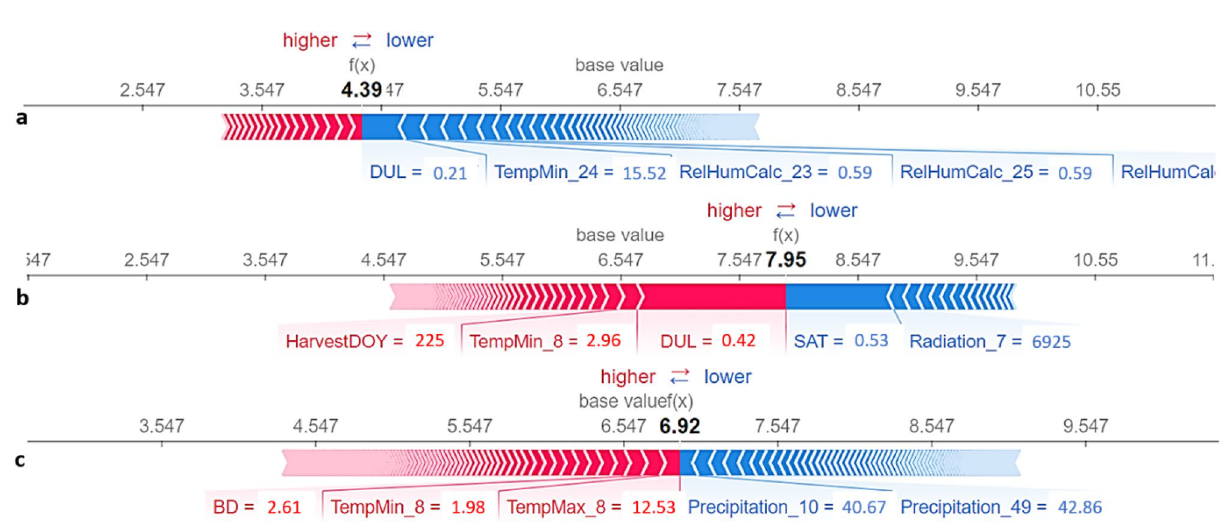
Figure 8. Force plots to explain the predicted yield values for instances with the minimum ( a ), maximum ( b ), and median ( c ) yield values in